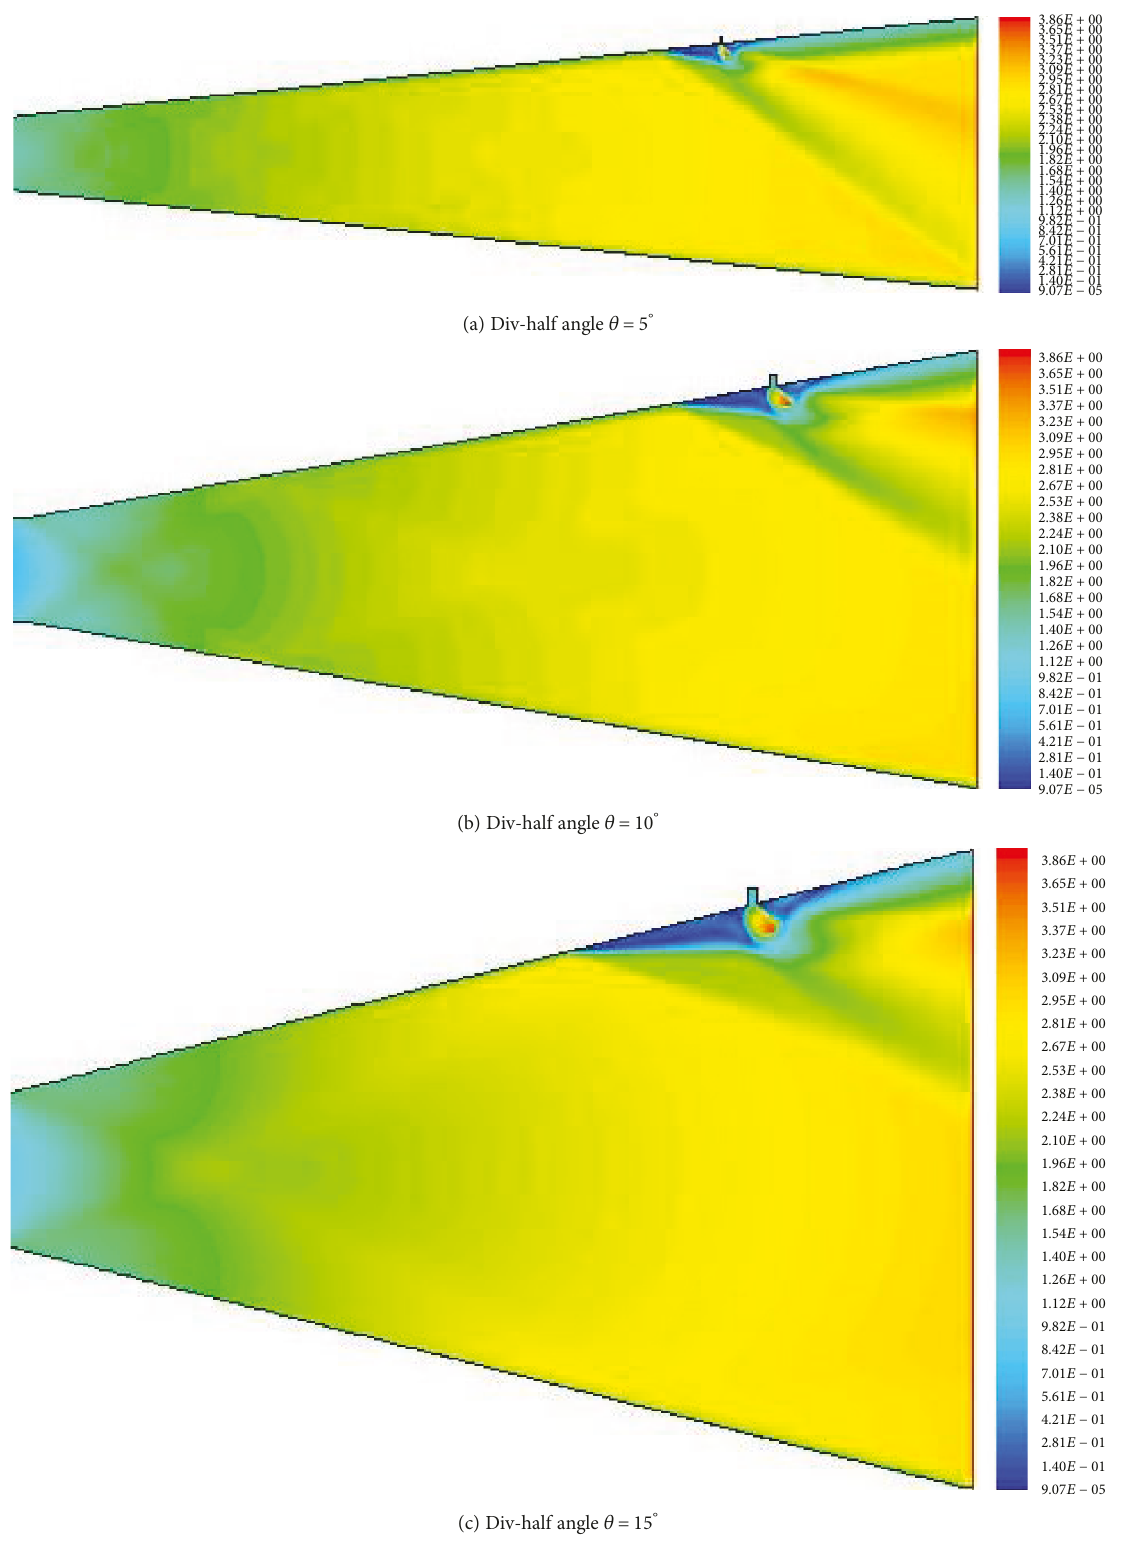
Figure 22: The in fl uence of primary nozzle divergence angle on fl ow fi eld structure (Mach number contour) M